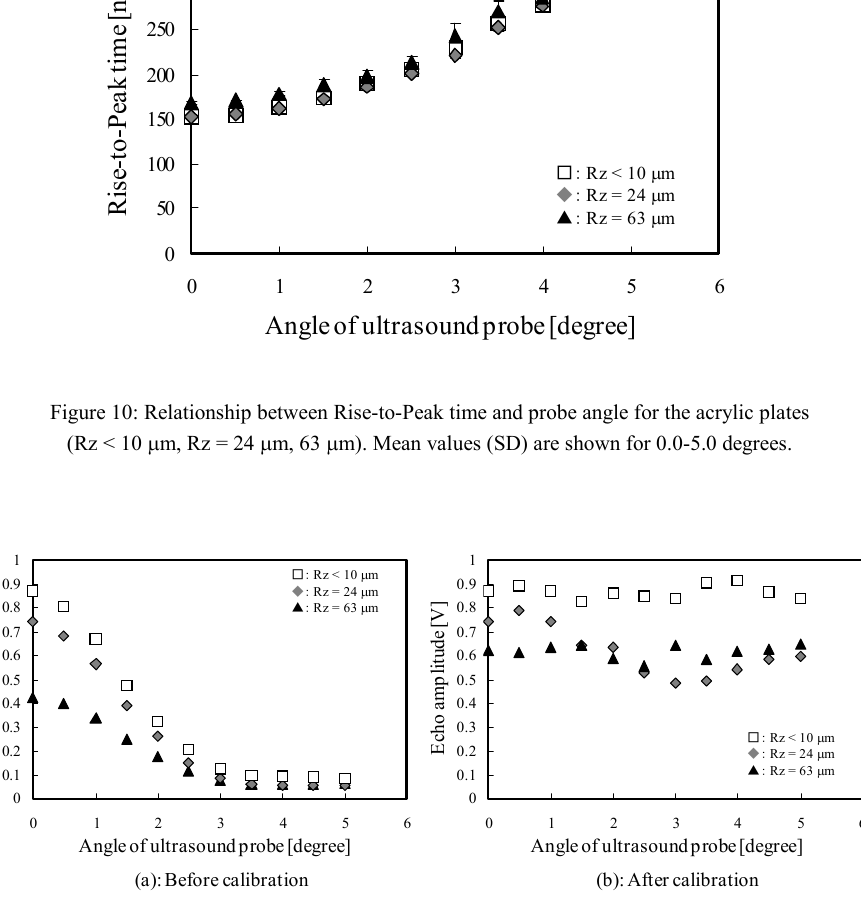
Figure 11: Relationship between echo amplitude and probe angle. The acrylic